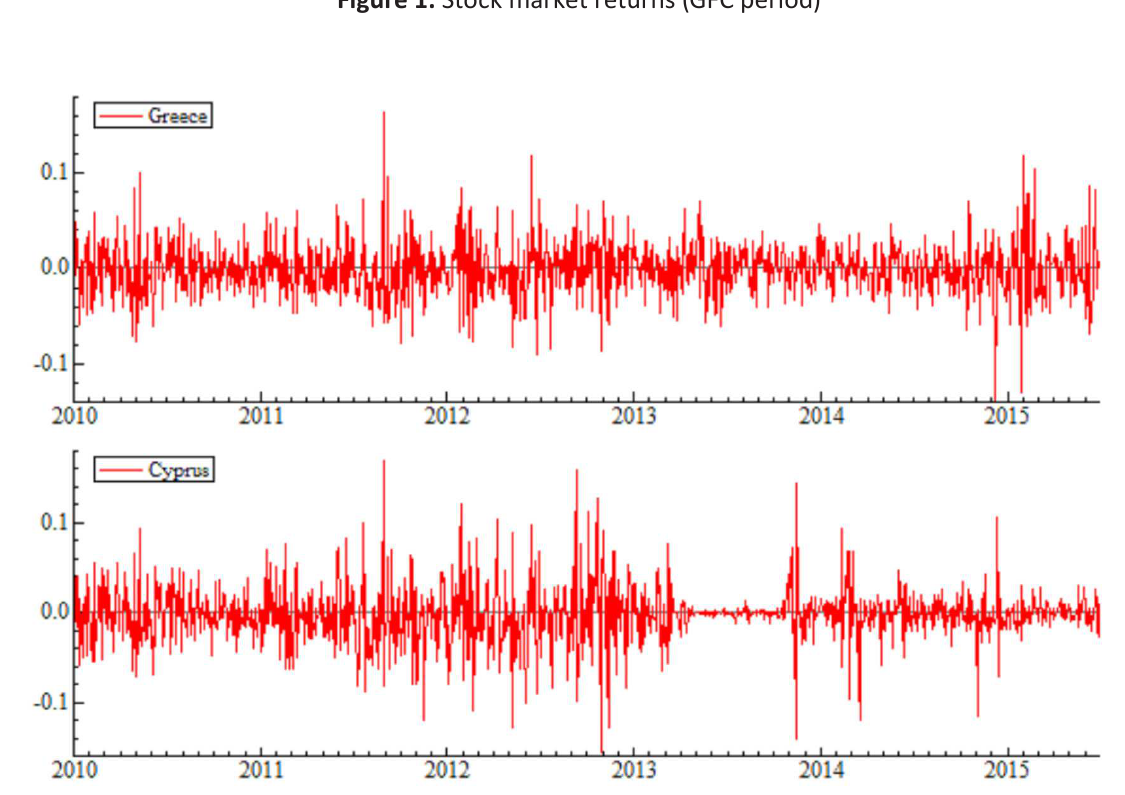
Figure 2. Stock market returns (EDC